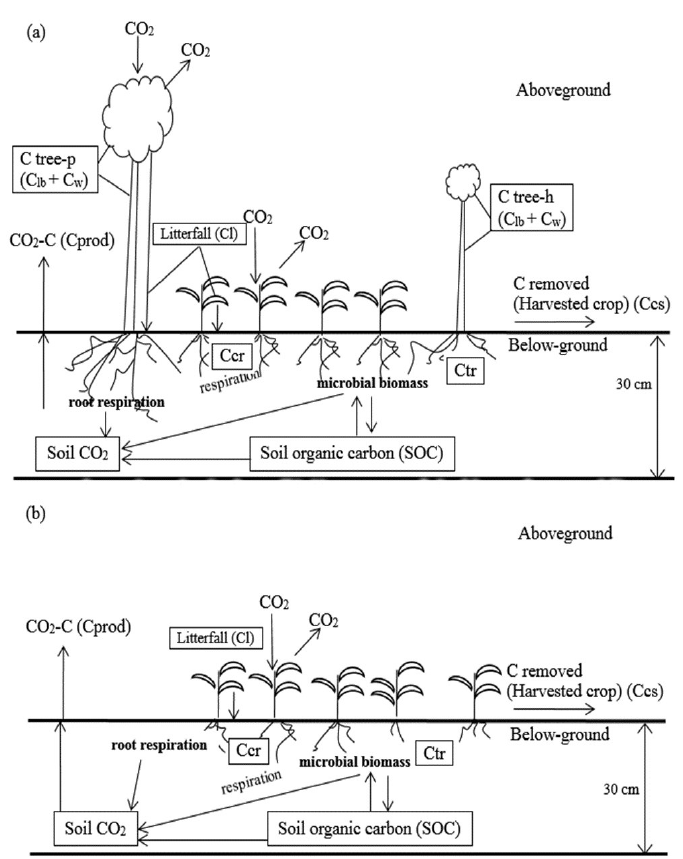
Figure 1. Diagram of C pools and C fluxes within ( a ) a tree-based intercropping (TBI) system; ( b ) a temperate agricultural (non-TBI) system for St. Edouard and St. Paulin sites, southern Quebec, Canada. Boxes indicate C pools and arrows indicate C fluxes. C l denotes litterfall (mixed species); C cs , crop biomass; C cr , crop roots; C tr , tree roots; C tree-h (C lb + C w ), hardwood components (wood, bark, branches, foliage (in tree, not litterfall from tree)); C tree p (C lb + C w ), poplar components (wood, bark, branches, foliage (in tree, not litterfall from tree)).